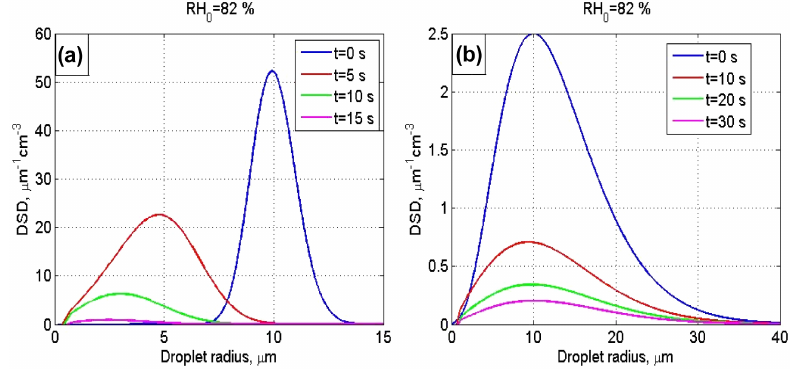
Figure 7. Time evolution of an initially narrow DSD (a) and an initially wide DSD (b) . The initial calculation parameters are the same in both examples: T 0 = 10 ◦ C, p = 829mb, RH 0 = 82% and q w0 = 0 . 587gm − 3 . The parameters of the initial Gamma distributions are given in Table 3.